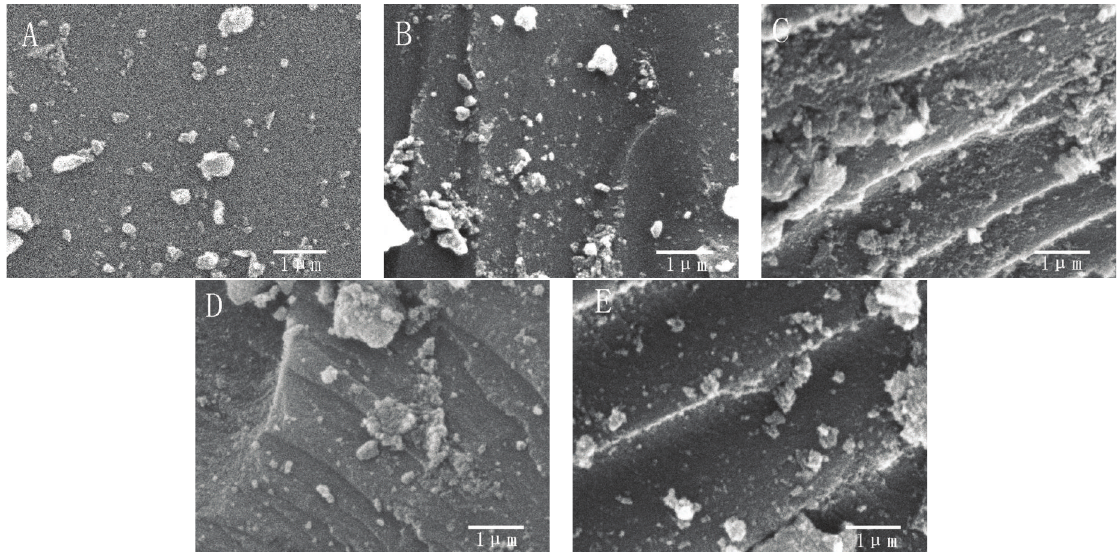
Figure 2: SEM images of mesoporous TiO 2 -Al 2 O 3 binary oxides prepared using di ff erent concentration of PEG1000. (a) 0mol/L, (b) 0.012 mol/L, (c) 0.030 mol/L, (d) 0.048 mol/L, and (e) 0.060 mol/L.